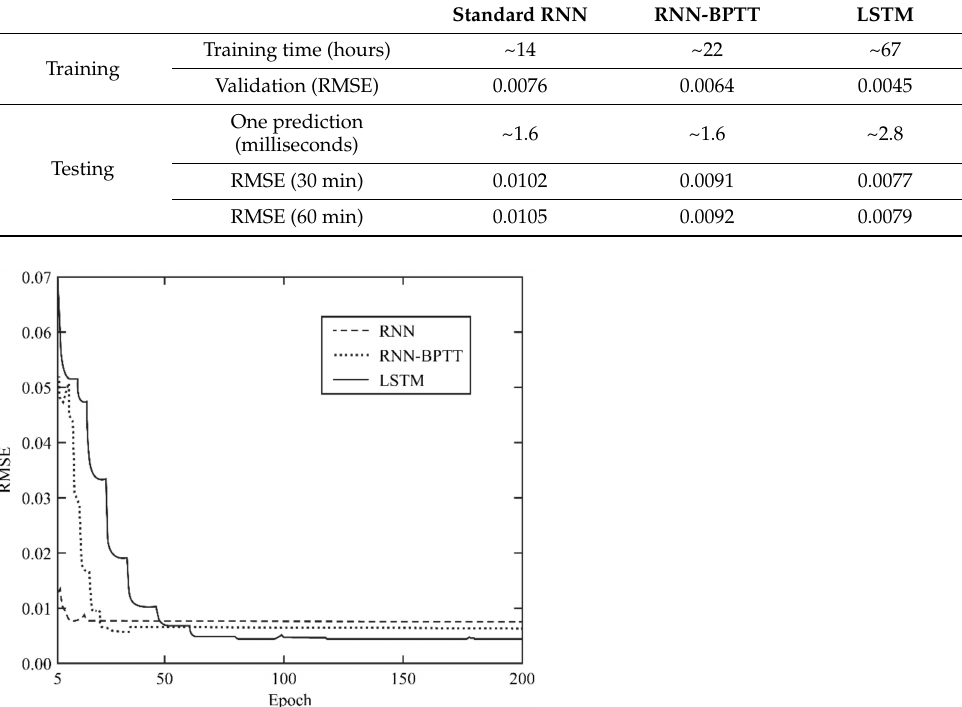
Table 1. Validation errors and prediction errors of the standard RNN, RNN-BPTT, and LSTM